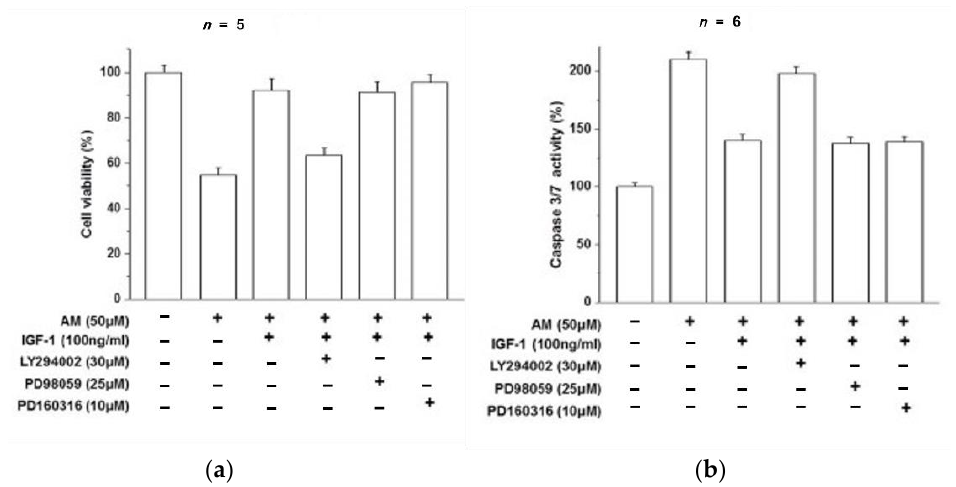
Figure 3. ( a ) The percentage of viable RPE cells decreases in response to AM exposure and is protected by IGF-1. Inhibiting the PI3K/Akt pathway by LY294002 causes a reduction in IGF-1 efficacy, while inhibiting MAPK by PD98059 or PD160316 has no effect on maintaining RPE cell viability by IGF-1 in the presence of AM. PI3K/Akt is the pathway by which IGF-1 protects RPE cells from AM toxicity. ( b ) Caspase 3/7 activity in RPE cells approximately doubles in the presence of AM compared to control, and IGF-1 attenuates this increase. Inhibiting the PI3K/Akt pathway by LY294002 diminishes apoptotic protection from IGF-1, while inhibiting MAPK by PD98059 or PD160316 has no effect on the ability of IGF-1 to reduce caspase 3/7 activity in the presence of AM [37].